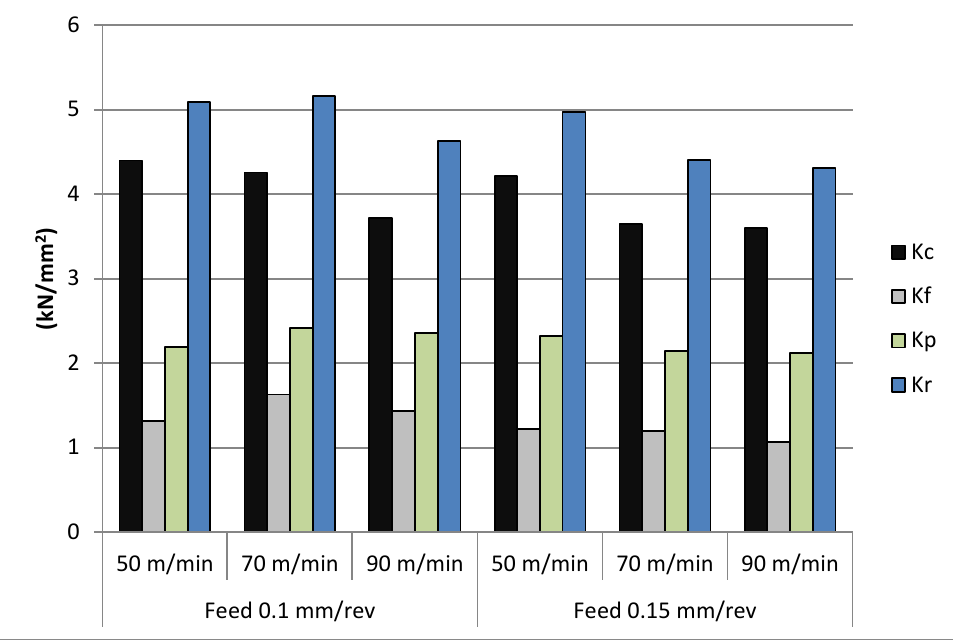
Figure 3. Initial k c , k f , and k p forces for turning tests on Haynes 282 with high pressure cooling.